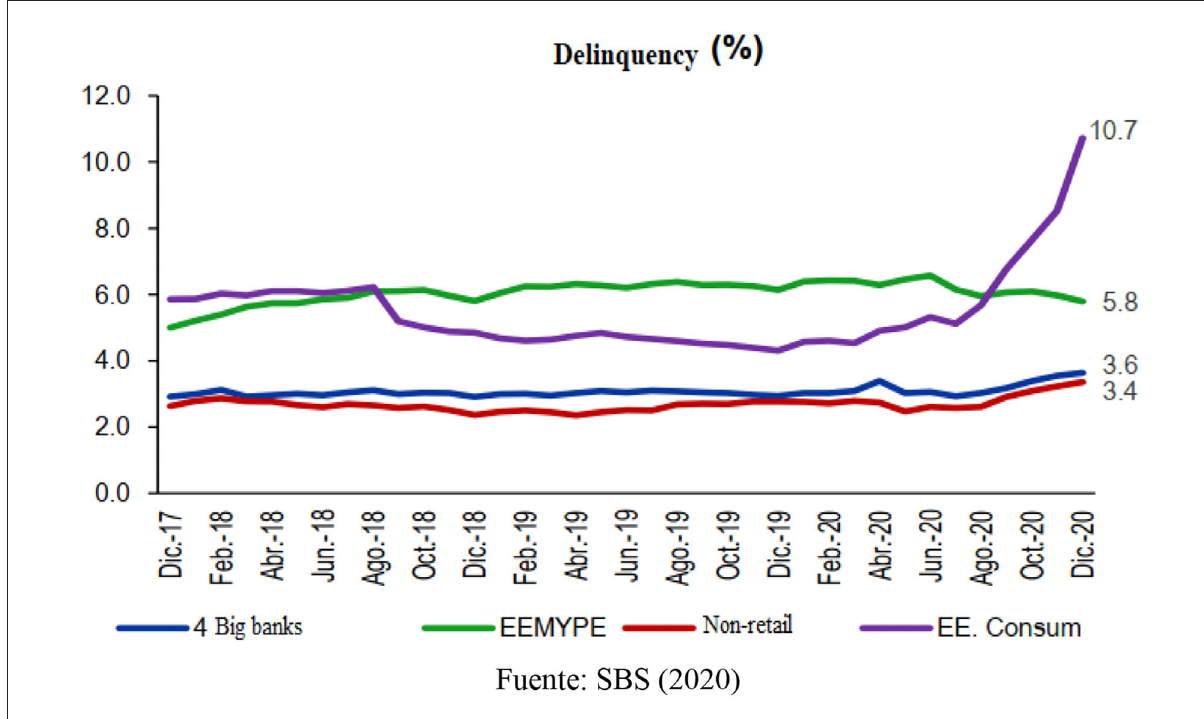
FIGURE2 Delinquency behavior. Fuente: SBS